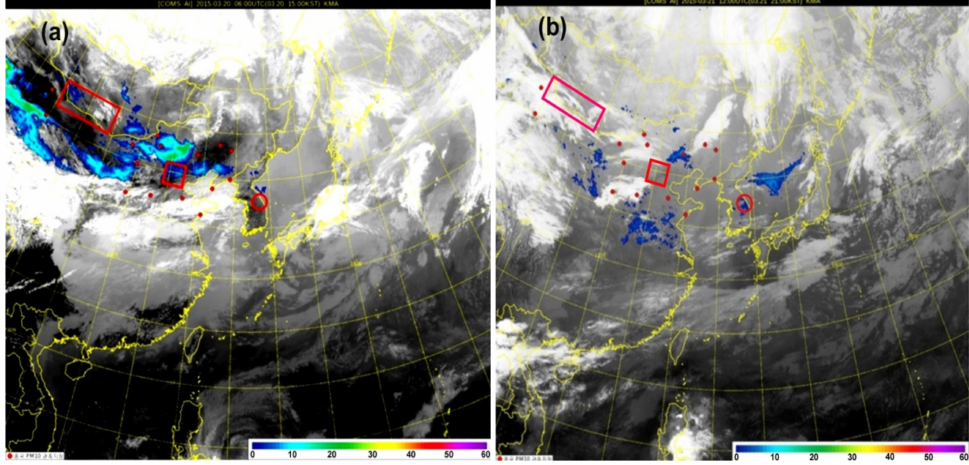
Figure 2. Korean COMS satellite images reflecting dusts at ( a ) 15:00 LST 20 March 2015 (before dust period at Gangneung city) and ( b ) 21:00 LST, 21 March (for dust period). Red small circle, small and big squares denote Gangneung (Korea), Beijing (China) and the Gobi Desert (Mongolia). (The Korea Meteorological Administration (KMA) supplied the images.) (http://www.kma.go.kr, accessed on 15 February